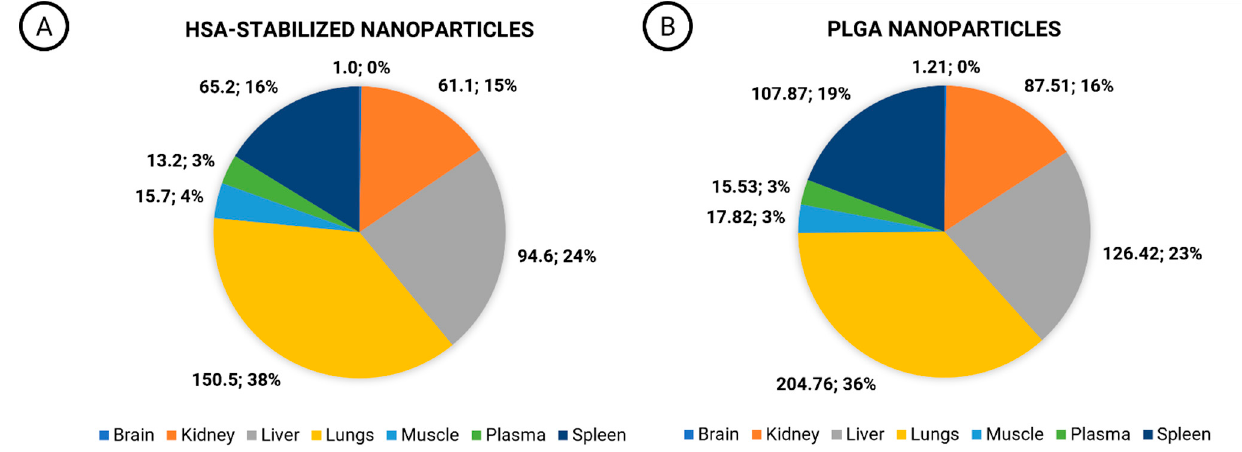
Figure 3. Comparison of the percentage exposure of HSA-stabilized rifabutin nanoparticles ( A ) and PLGA nanoparticles ( B ) based on AUC last (h · µ g · mL − 1 ), n = 6. The study served as confirmation that differences in plasma pharmacokinetics are a reflection of differences in their biodistribution and, due to their material attributes, both formulations are inequivalent regarding their in vivo performances.